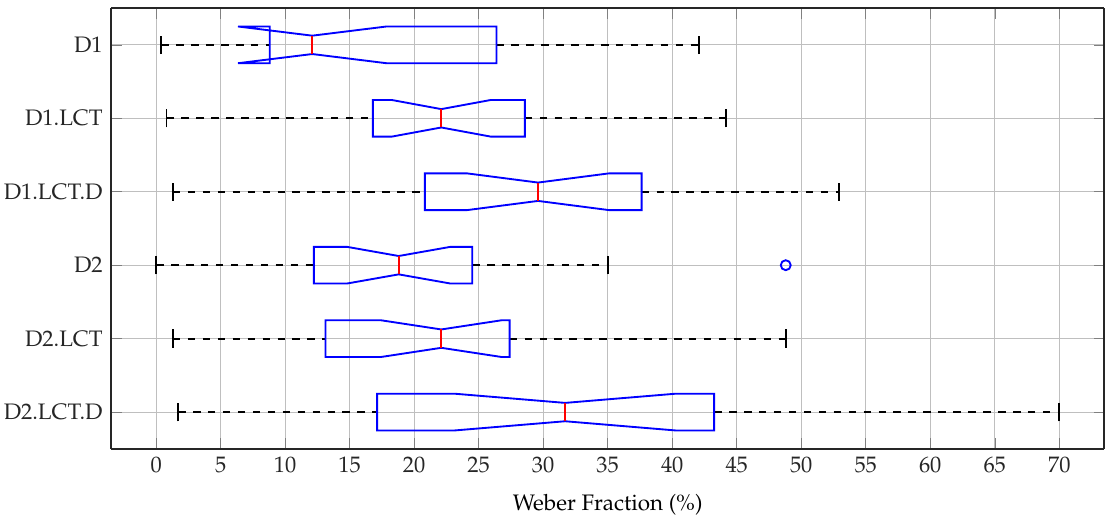
Figure 9. Boxplots of obtained differential thresholds given as Weber fractions.